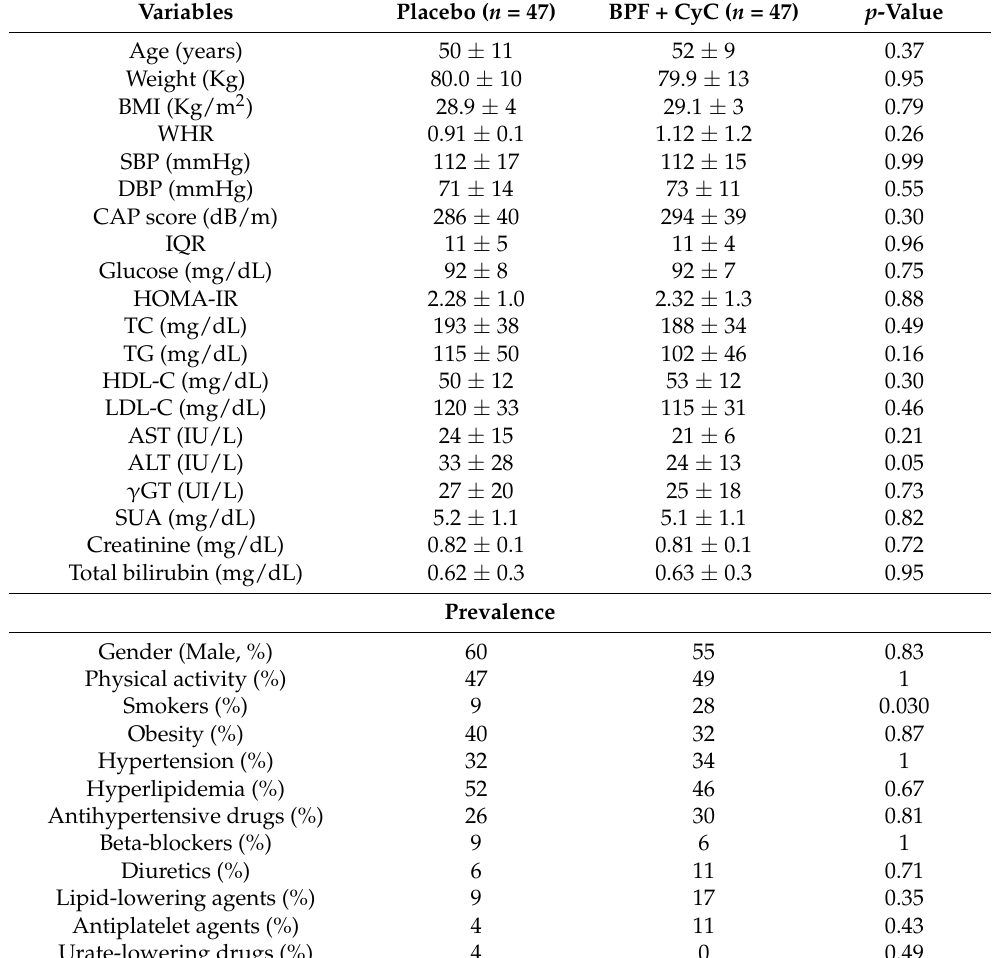
Table 1. Baseline demographic and clinical characteristics of individuals with NAFLD according to the